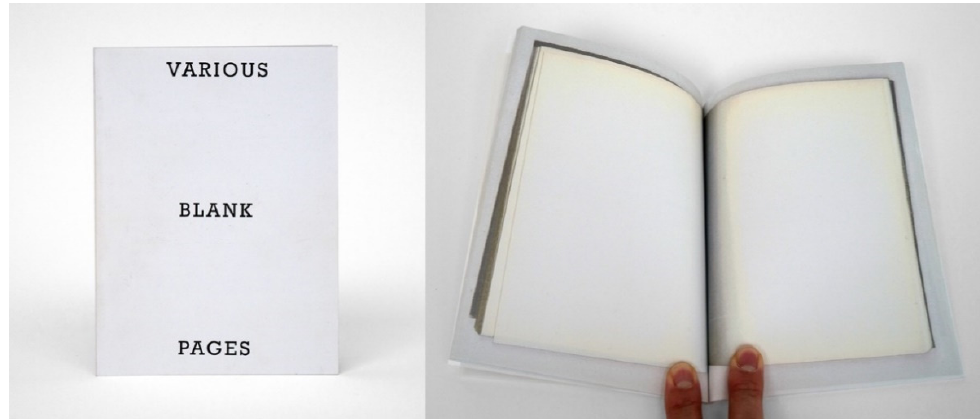
Figure 26. Doro Boehme and Eric Baskauskas, Various Blank Pages , 2009.